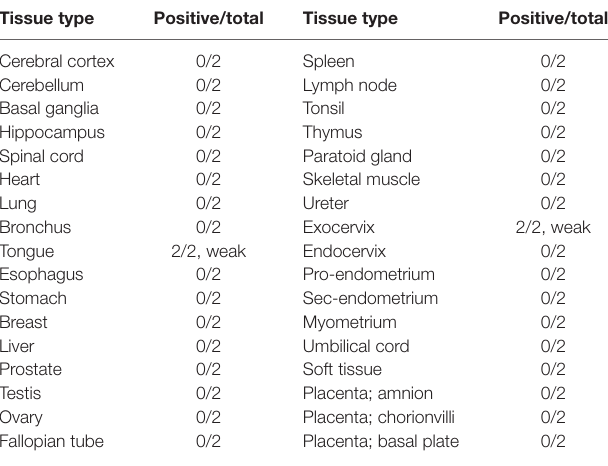
TaBle 2 | Immunohistochemistry profile of NEO-201 staining of normal human microarray tissues. Tissue